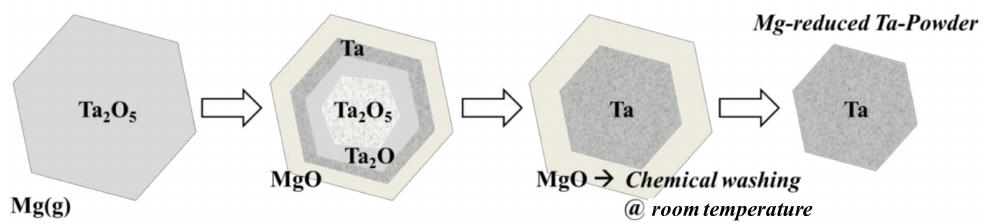
Figure 5. Schematic concept of the reduction behavior from Ta 2 O 5 to Ta via magnesium gas.